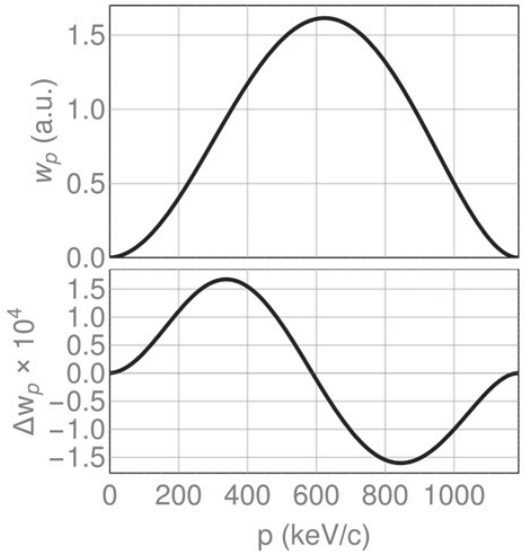
Figure 1. Top: The electron momentum spectrum in free neutron decay for the SM value of b = 0. Bottom: Deviation for other value of b = 0 .